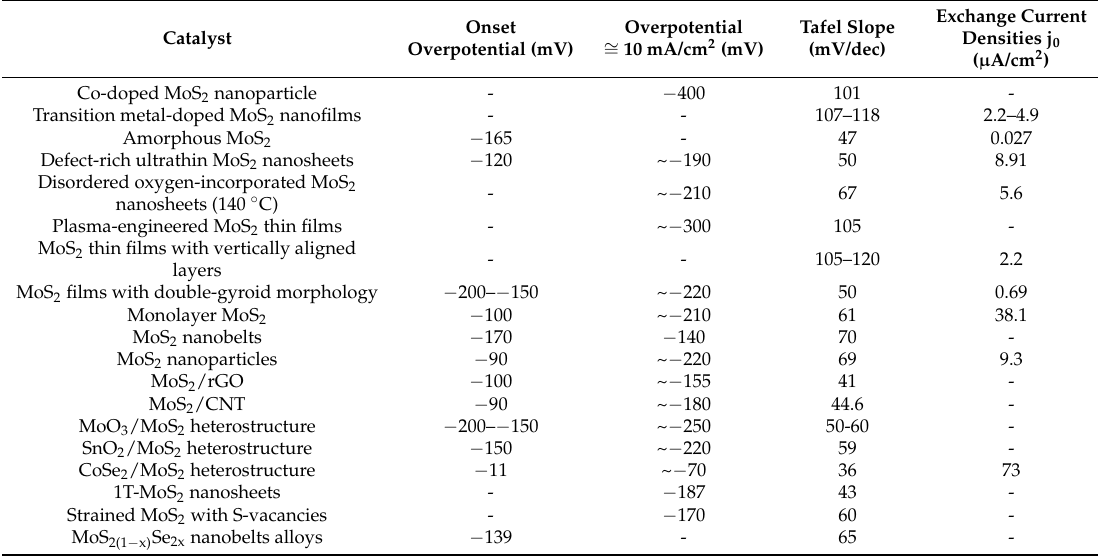
Table 1. Onset overpotentials, overpotentials ∼ = 10 mA/cm 2 , Tafel slopes, and exchange current densities of different MoS 2